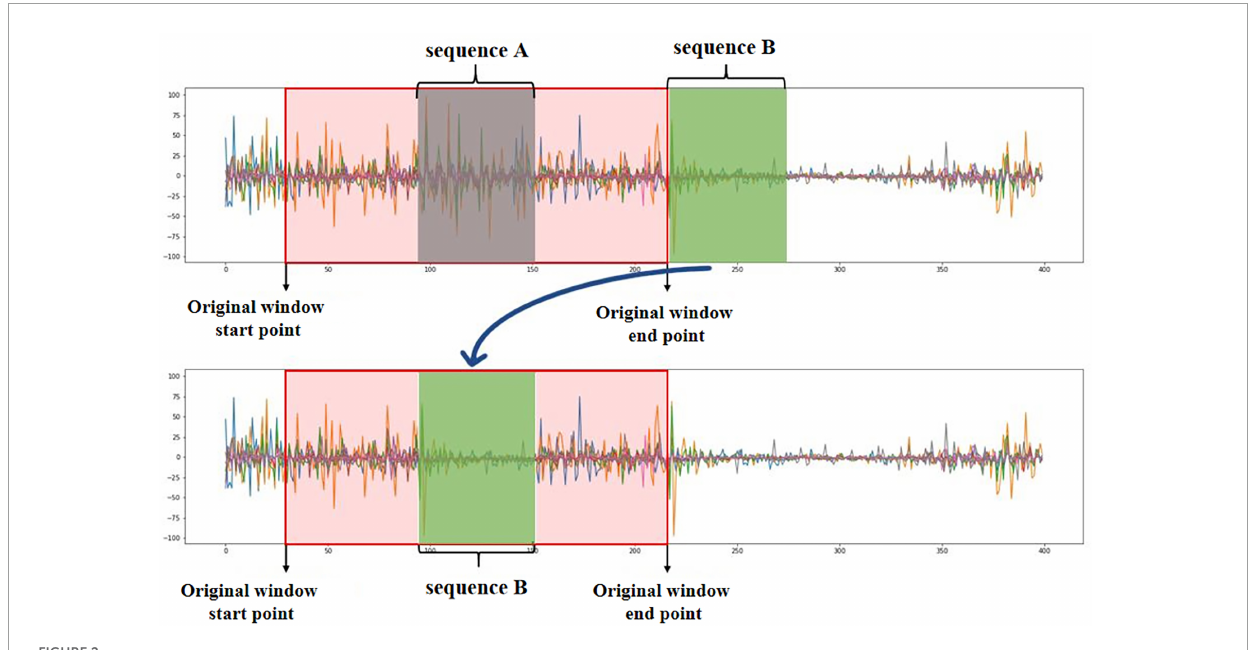
FIGURE2 Schematic diagram of time-delay enhancement